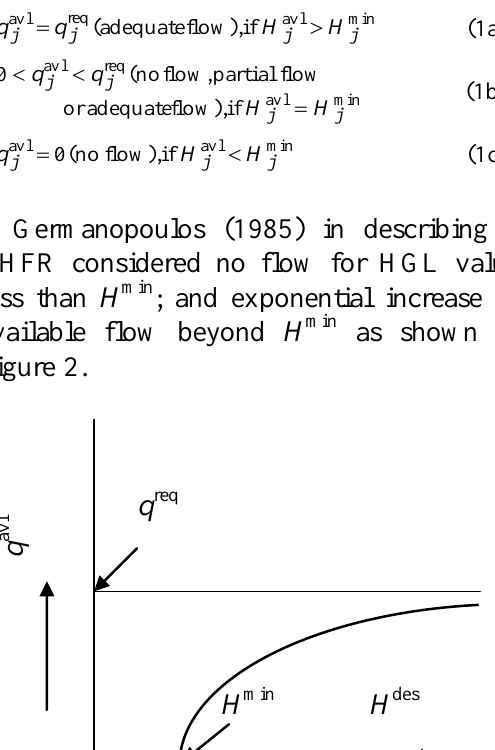
Fig. 3. NHFR by Wagner et al.